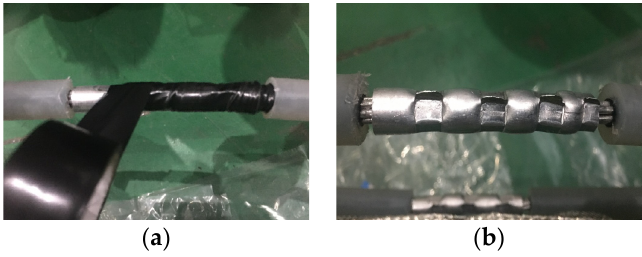
Figure 14. Schematic diagram of cable defects. ( a ) The insulating tapes are used as semi-conductive tapes by mistake; ( b ) The metal tips are not polished.